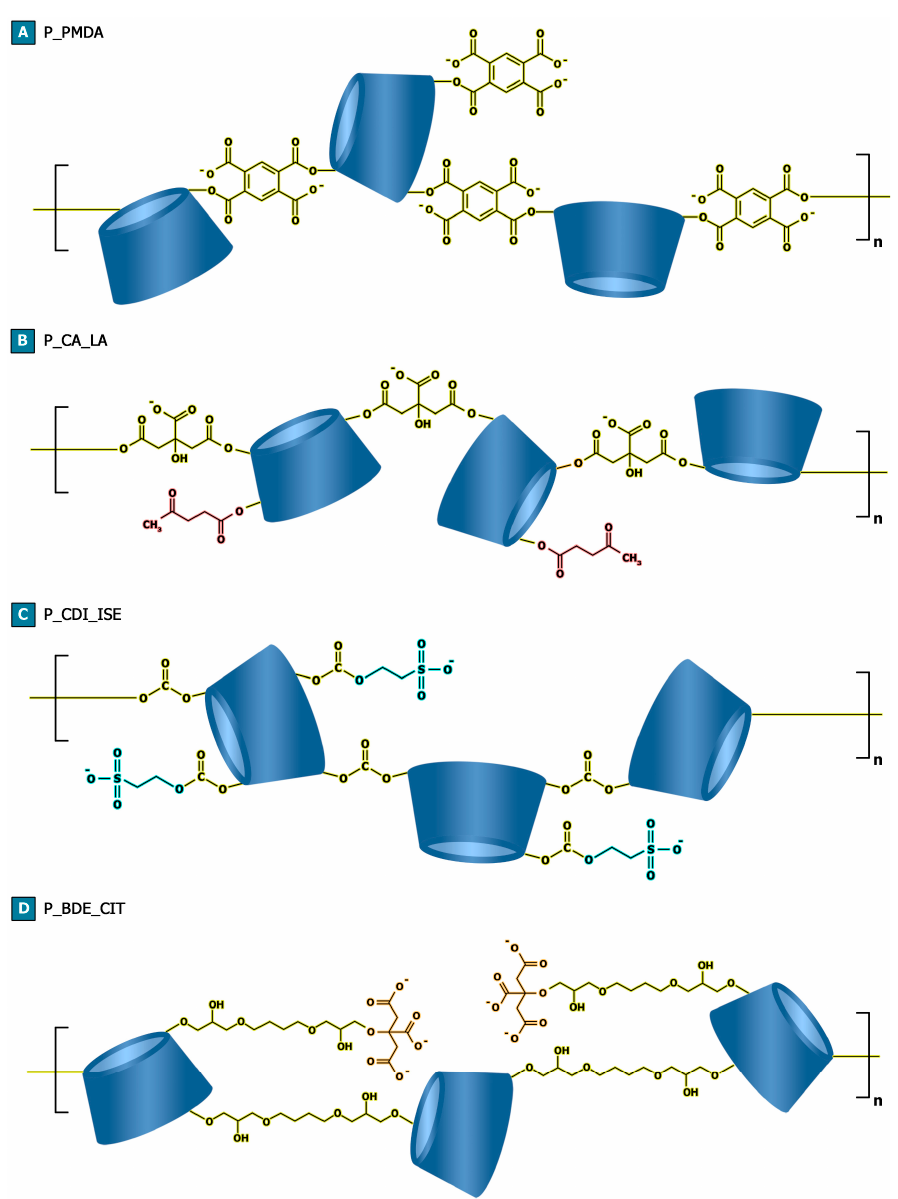
Figure 1. Schematic representation of ( A ) P_PMDA, ( B ) P_CA_LA ( C ) P_CDI_ISE, and ( D ) Schematic representation of ( A ) P_PMDA, ( B ) P_CA_LA ( C ) P_CDI_ISE, and P_BDE_CIT. ( D )